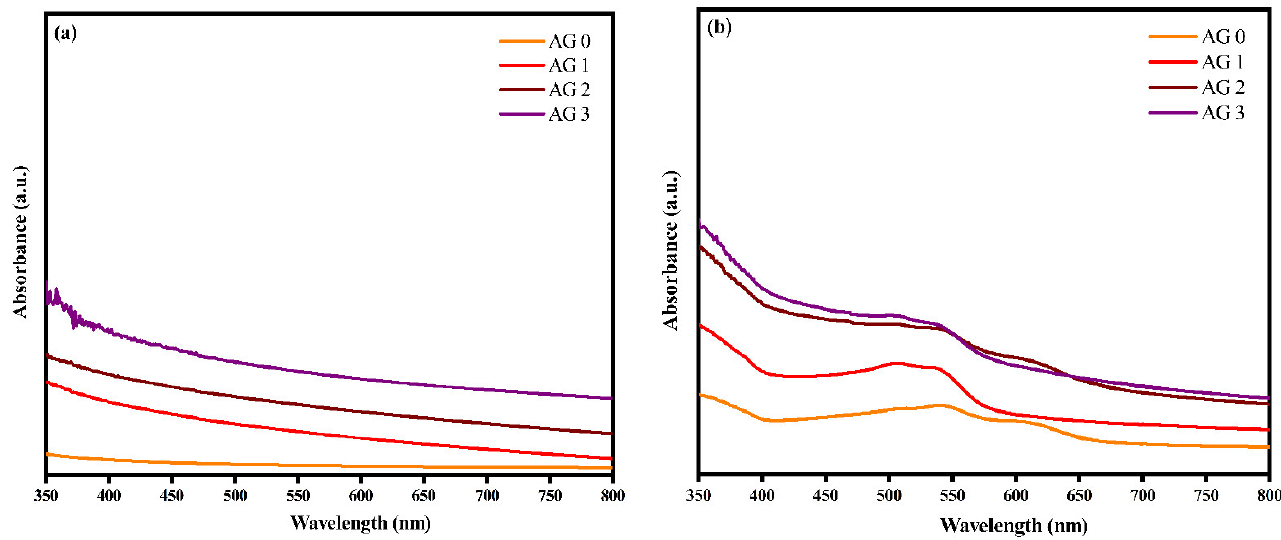
Figure 4. UV–vis spectra of agar/zeolite/CMC/PVA biomembrane: ( a ) before and ( b ) after adsorp- tion of CR.